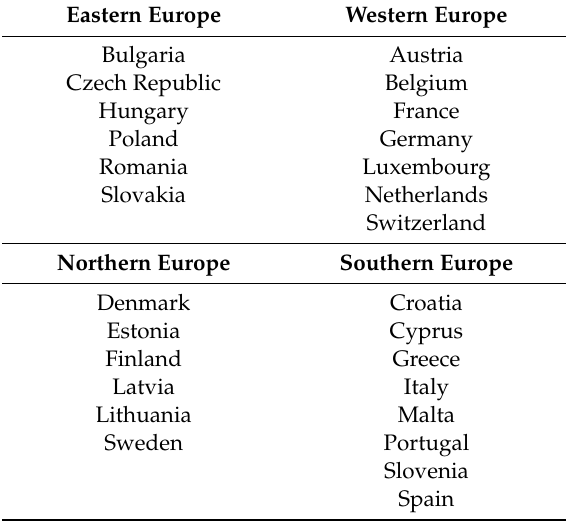
Table A5. Country groupings based on the UN